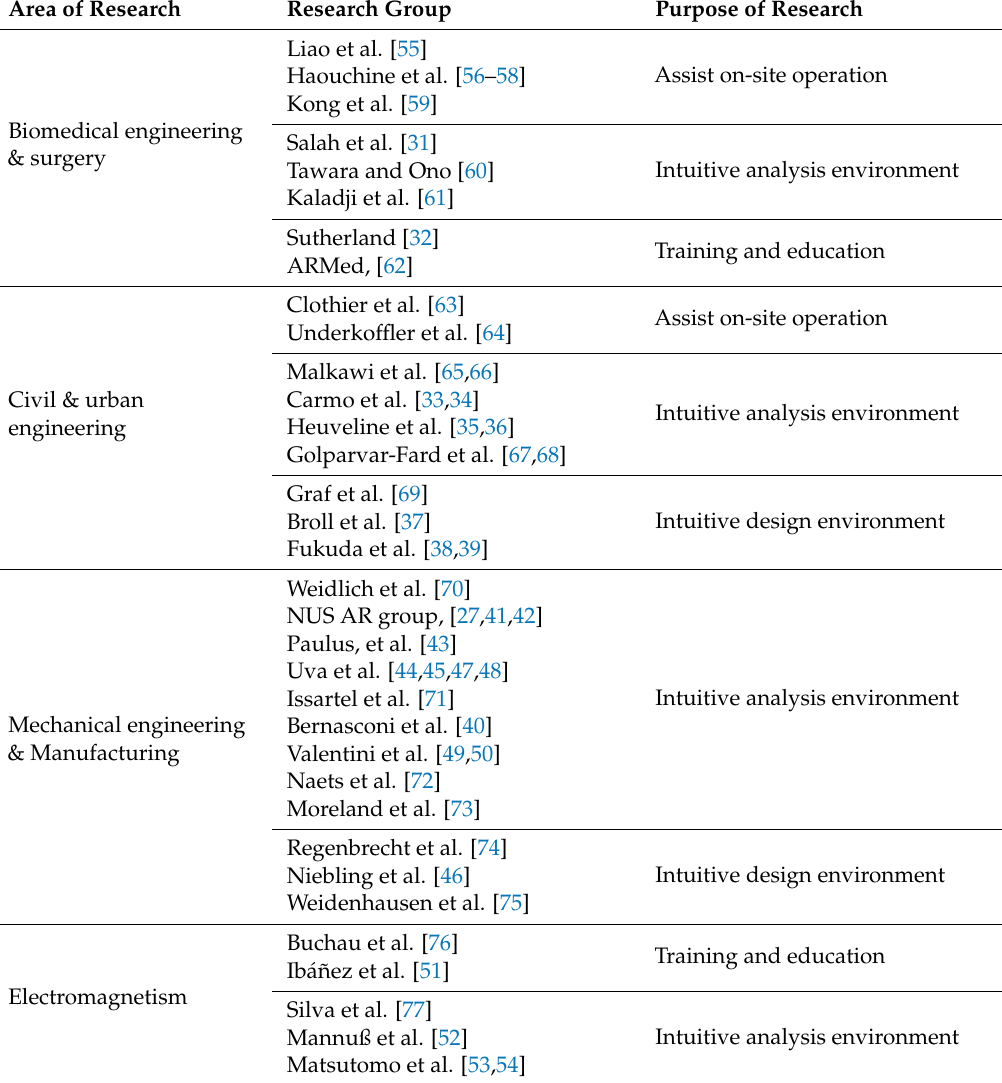
Table 1. Research area and purpose of AR-based engineering analysis and